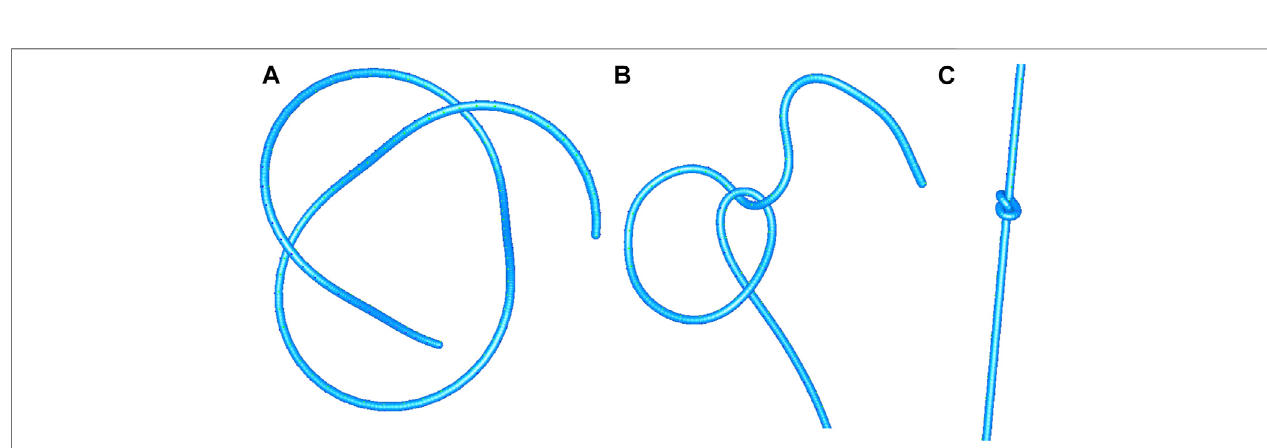
FIGURE 8 | A suture thread is wrapped around a fi xed rigid cylinder by pulling at its ends. The wrapping motion is sampled at time 0 [ s ] (A) , 0.5 [ s ] (B) , and 1 [ s ] (C) . The model remains inextensible during this simulation, which is why the loops around the rigid cylinder get closer and closer.